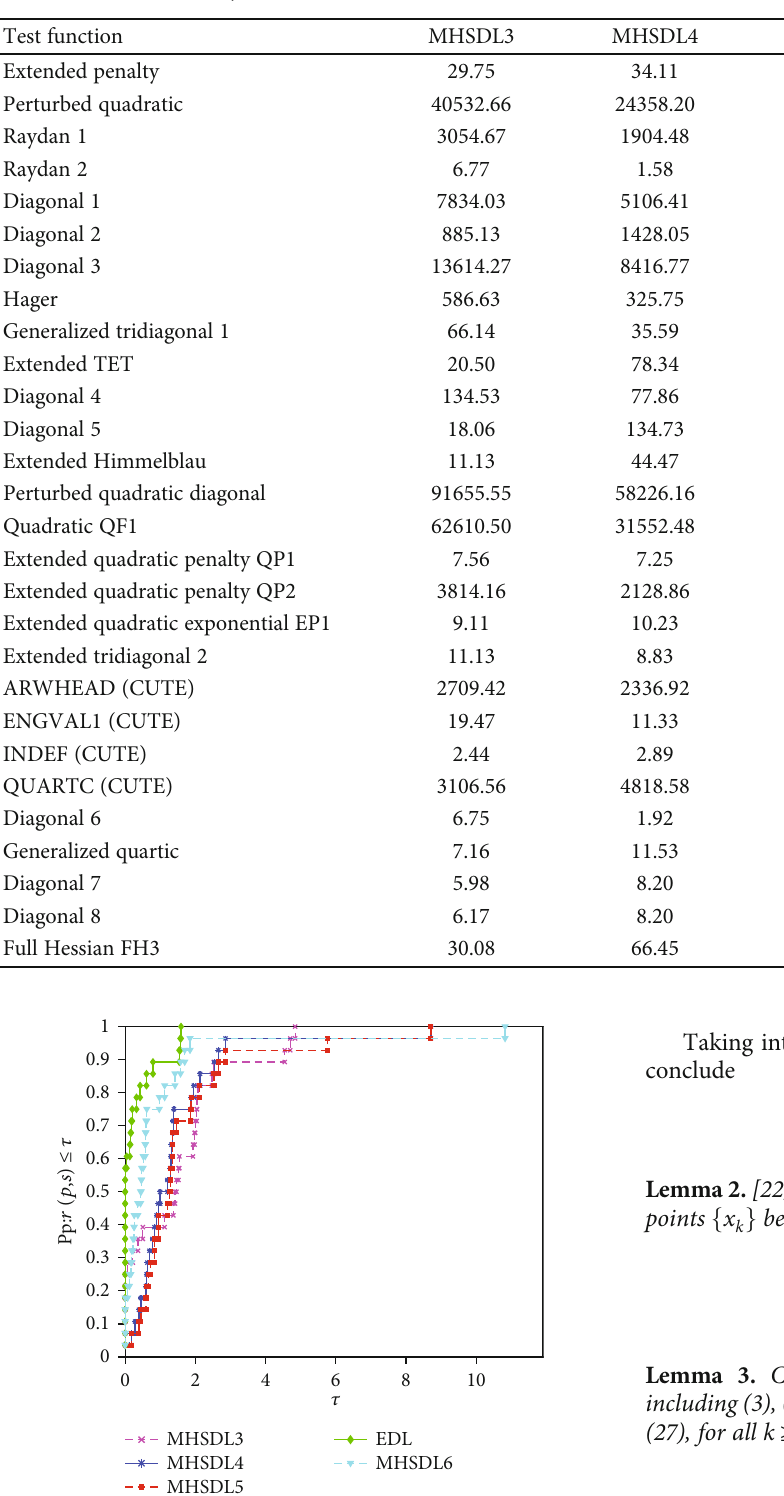
Table 3: Summary results of EDL, MHSDL3, MHSDL4, MHSDL5, and MHSDL6 methods with respect to CPU time (sec).